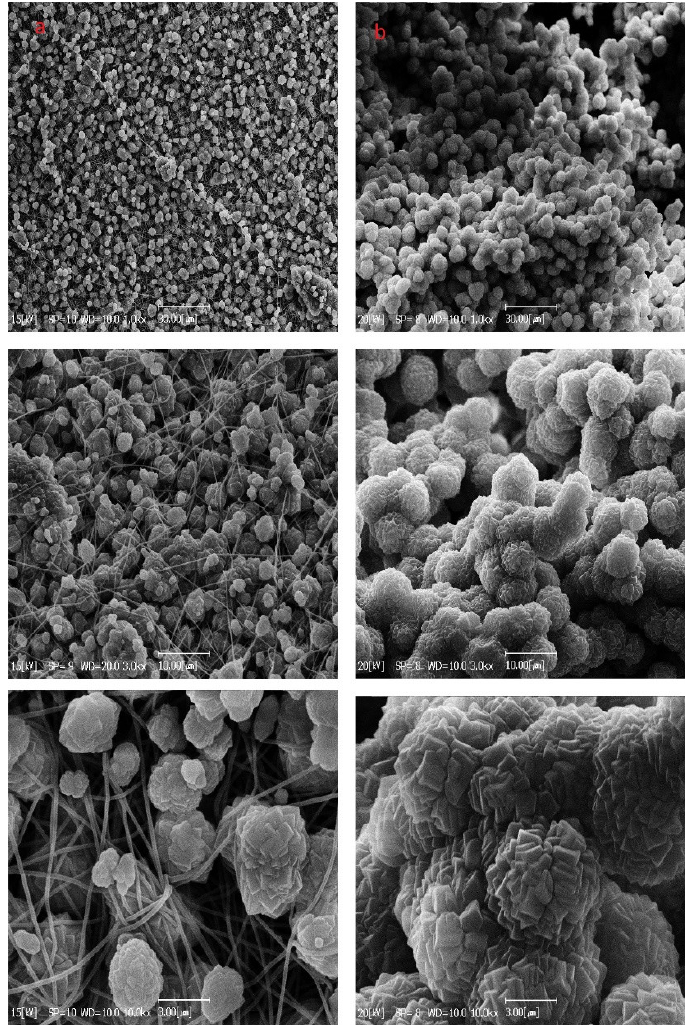
Figure 10. SEM images of MOFs growth on the nanofibers, ( a ) first cycle, ( b ) second cycle, at different magnifications.